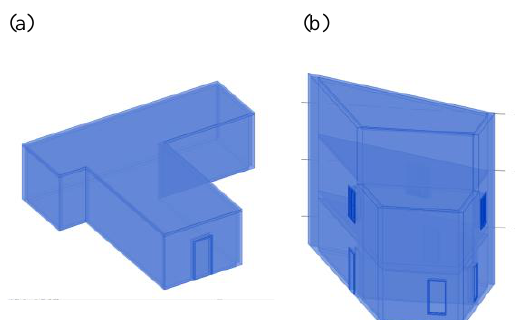
Figure 4 . Visualization of as-planned models from (a) dataset 1, and (b) dataset 2.